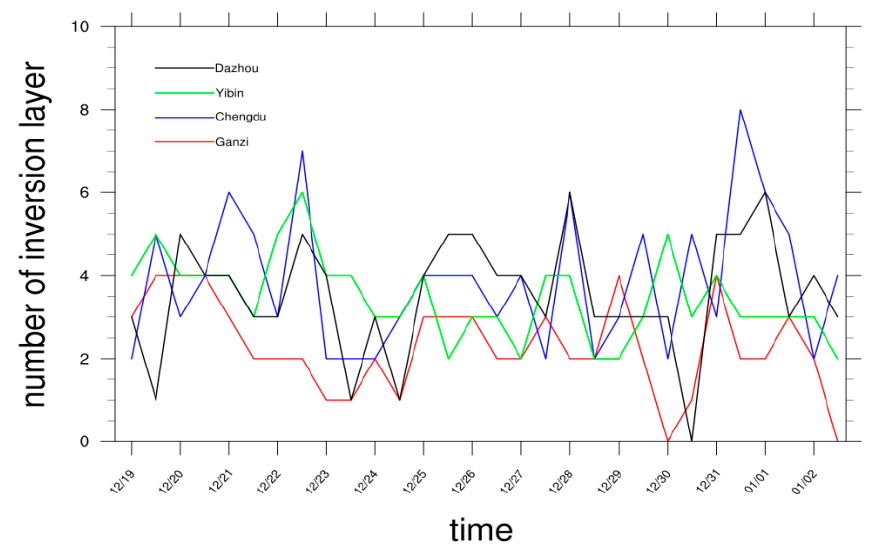
Figure 9. The number of inversion layers in Dazhou, Yibin, Chengdu and Ganzi.